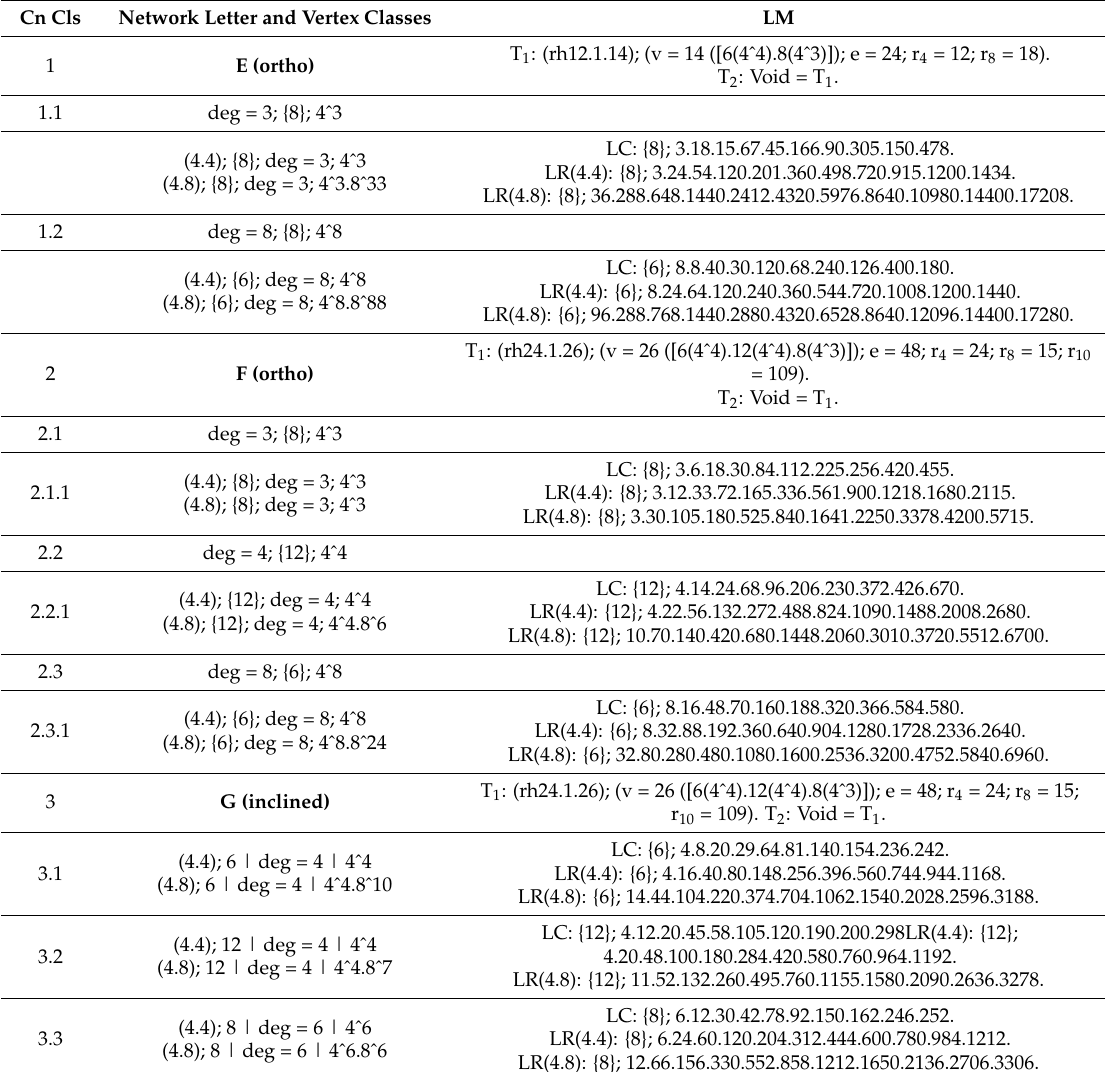
Table A2. Spongy corner coalesced networks: unit/tile; vertex connectivity classes; ring domain; population; degree; point symbol; LM sequence: connectivity (LC) and atom surrounding rings (LR).